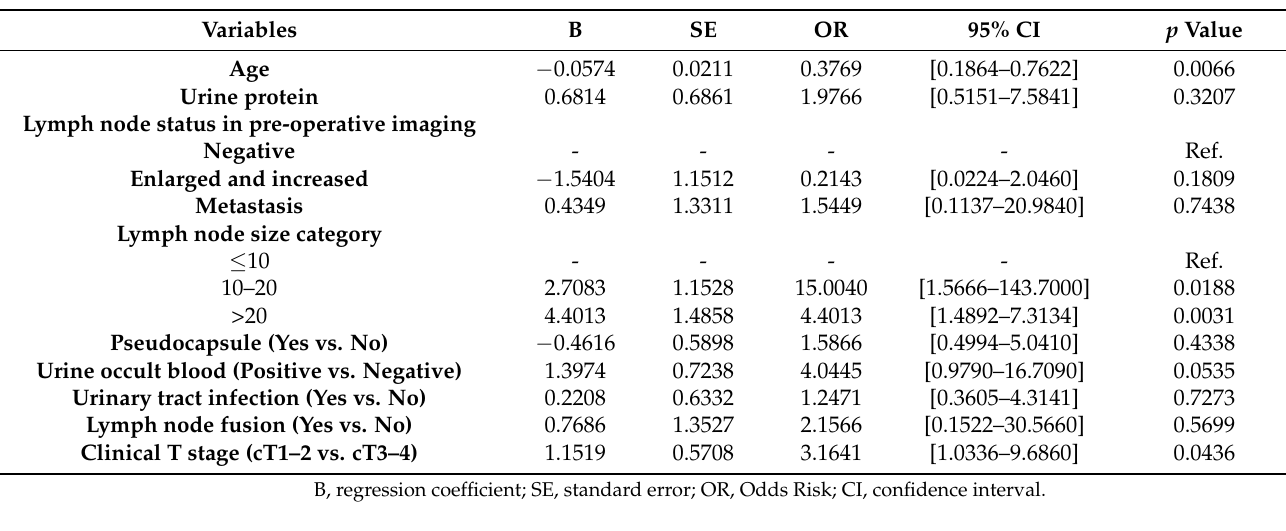
Table 2. Multivariable logistic regression analysis of predictors of lymph node metastasis.